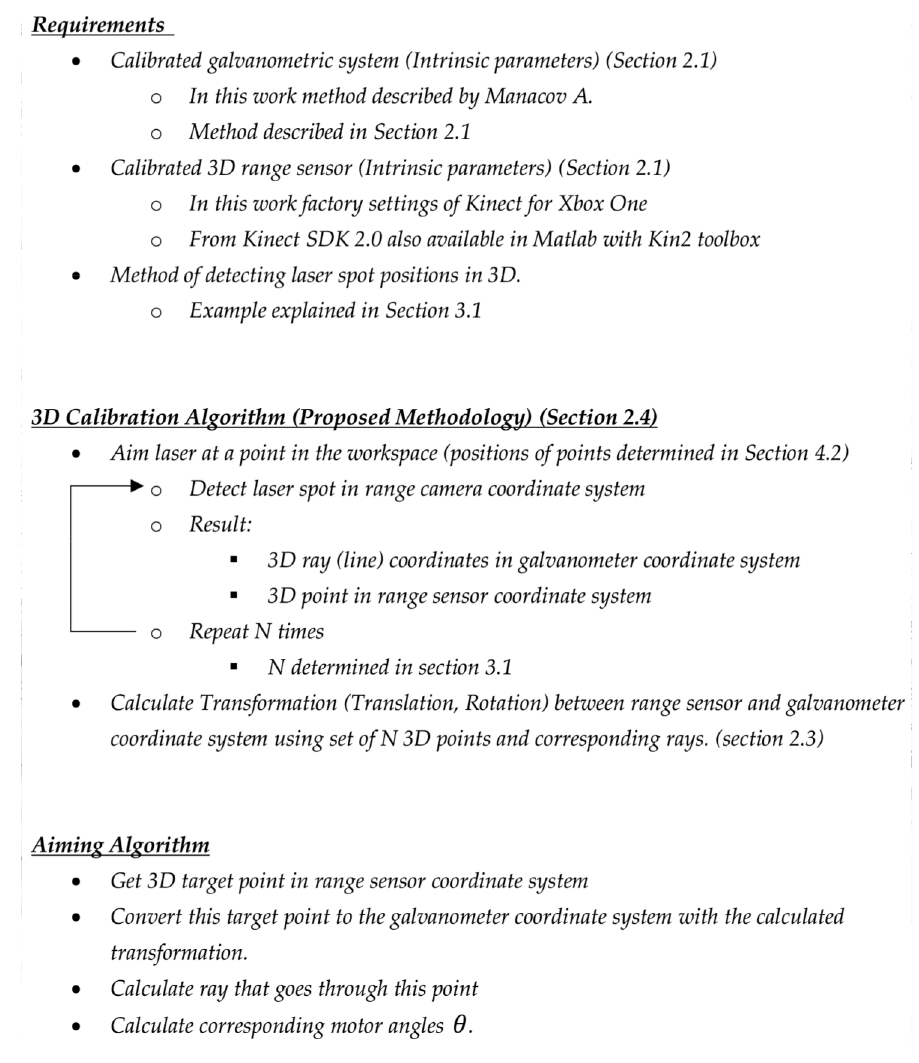
Figure 2. Overview of the complete proposed process used in the paper from preconditions [16–18] and three-dimensional (3D) calibration to aiming towards a selected point